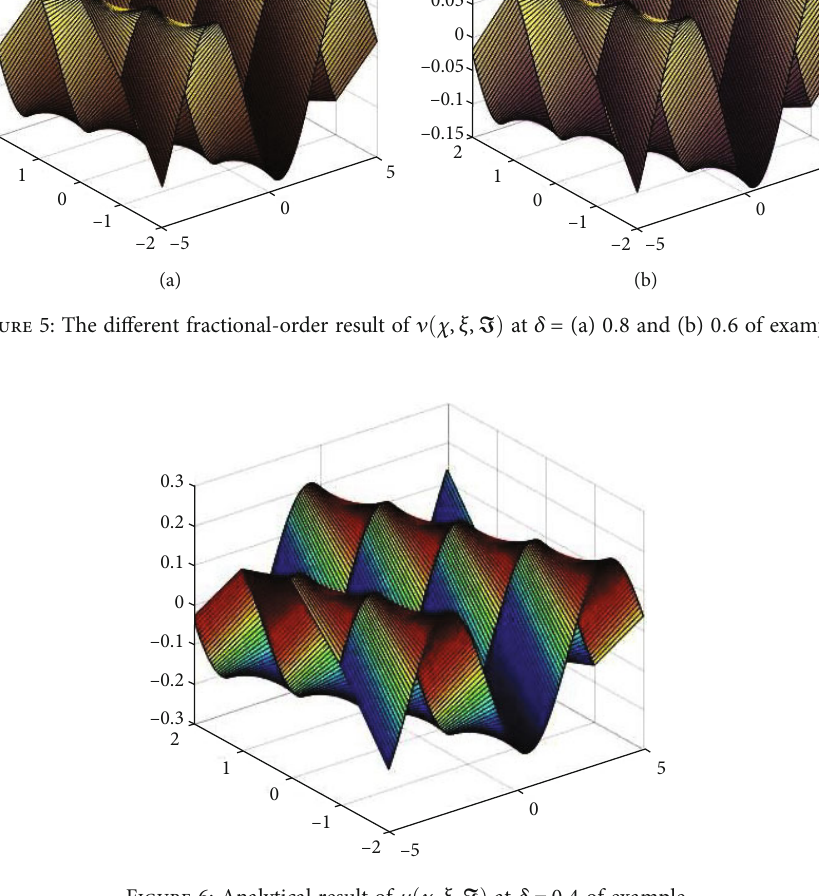
Figure 6: Analytical result of μ ð χ , ξ , I Þ at δ = 0 : 4 of